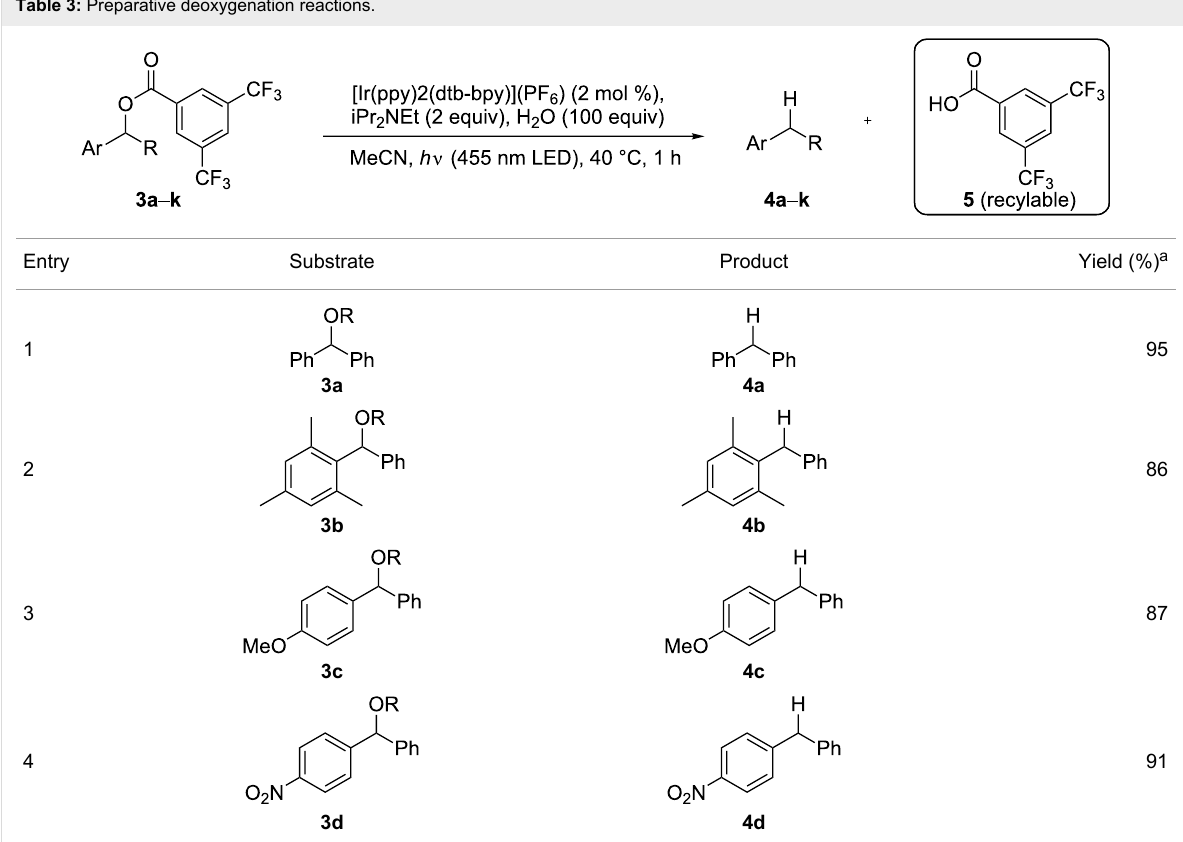
Table 3: Preparative deoxygenation